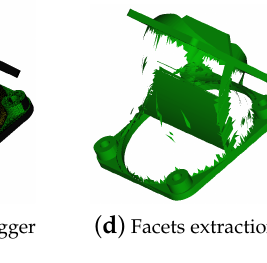
Figure 12. Curvature shift on the fan duct.